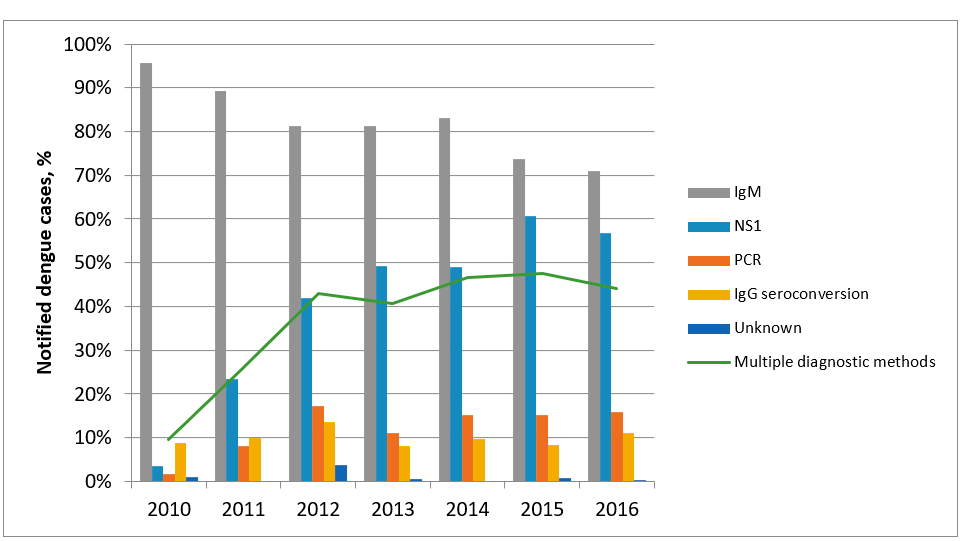
Figure 4. Proportion of notified dengue cases by diagnostic method and year, Victoria 2010–2016.